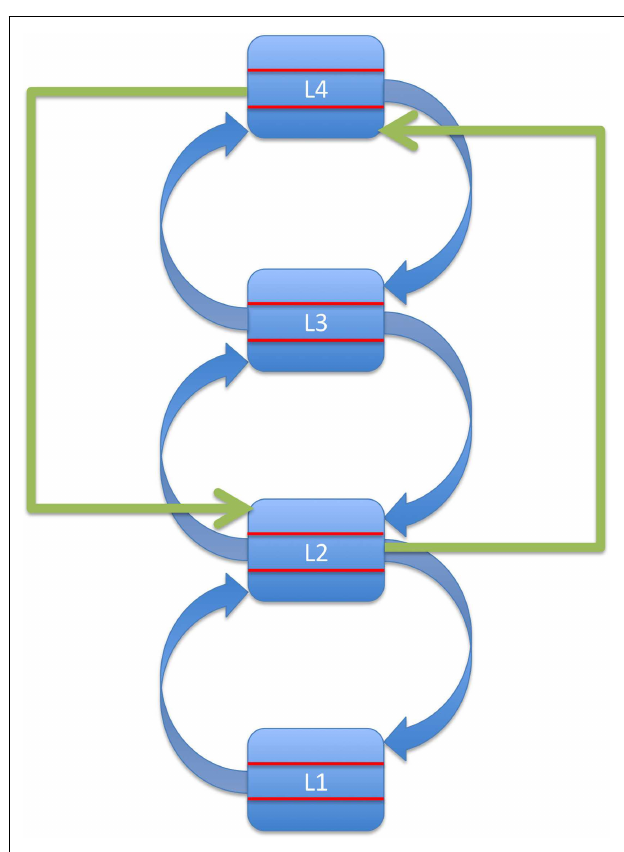
FIGURE 2 |Top-down effects as direct influences of a source region located at least two levels above the target region in a hierarchical predictive-coding